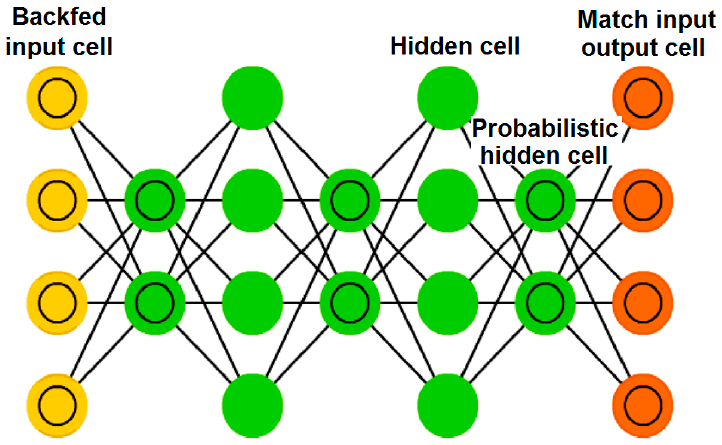
Figure 5. Architecture of Deep Belief Network.